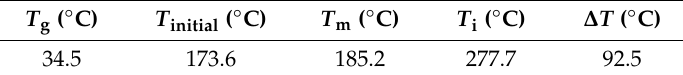
Table 2. DSC data of PSCTLCP in nitrogen atmosphere.